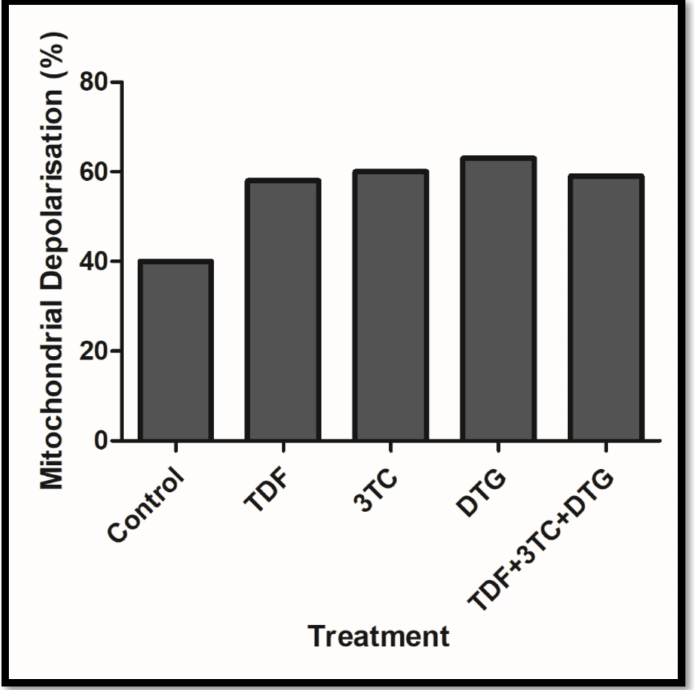
Figure A1. Percentage of mitochondrial depolarisation following treatment. All treatments showed an increase in depolarisation however values were not